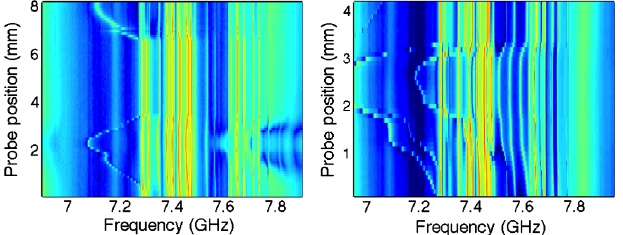
FIG. 6. Transmission spectra for different lateral probe posi- tions. (a) Starting on a ground plane, the probe is moved across one lattice resonator, traverses the ground plane, and stops when it is centered on a second lattice resonator. Significant shifts of the lowest-frequency mode result when the probe is centered on one resonator; no shifts occur when it is in contact with a ground plane. (b) Starting at the edge of a three-way coupling capacitor, the probe is moved across the capacitor, then off the capacitor and onto a lattice resonator. When the probe covers a three-way capacitor, three lattice sites are perturbed simultaneously, result- ing in multiple modes shifting down in